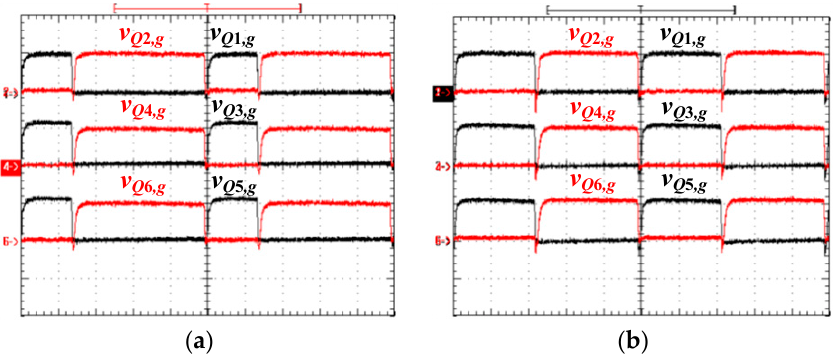
Figure 7. PWM signals of Q 1~ Q 6 under ( a ) 20% load; ( b ) full load [ v Q 1 ~ v Q 6 : 10 V/div; time: 2 µs].